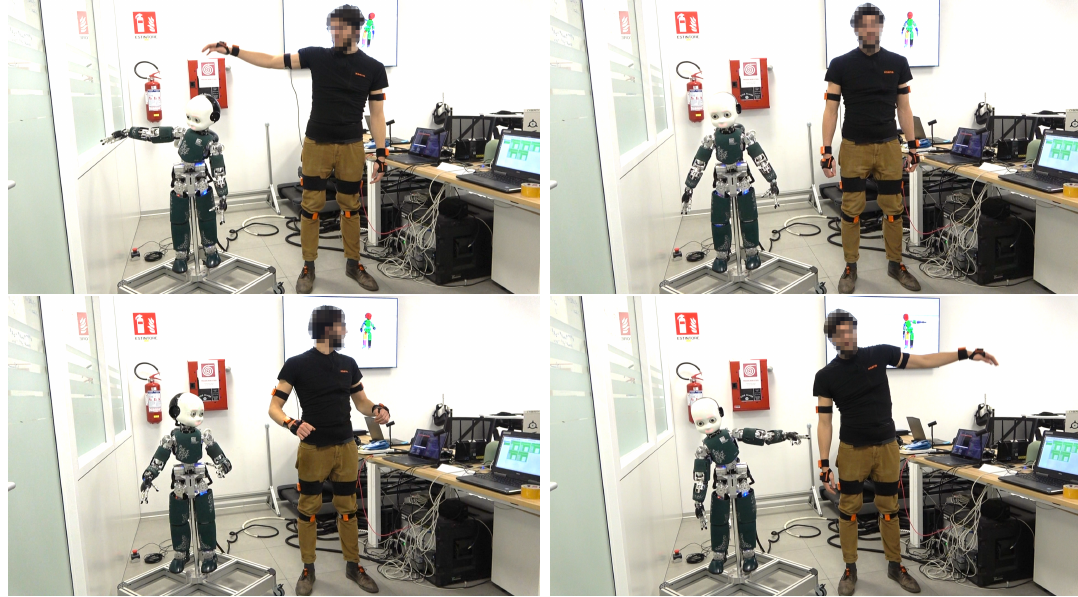
Figure 5. Real-time retargeting of the human motion to iCub humanoid robot